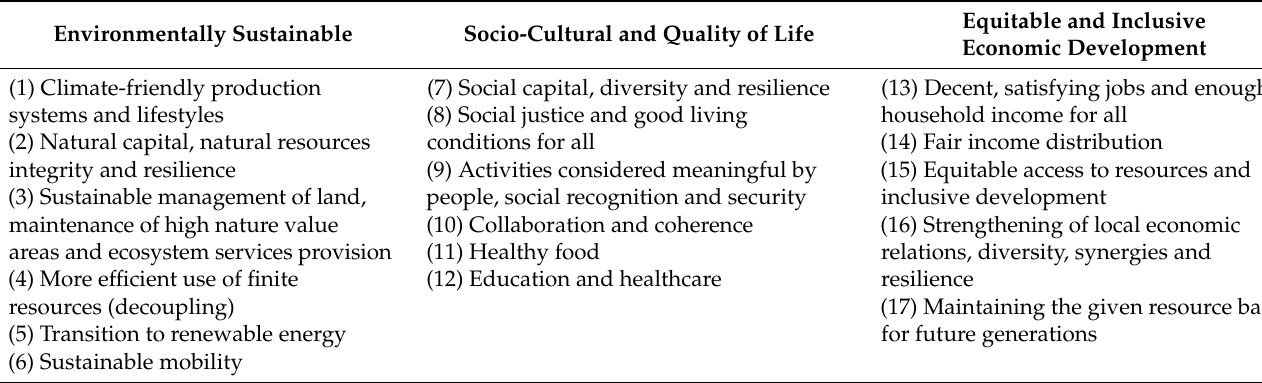
Table 1. Key dimensions and criteria of sustainable wellbeing. Environmentally Sustainable Socio-Cultural and Quality of Life